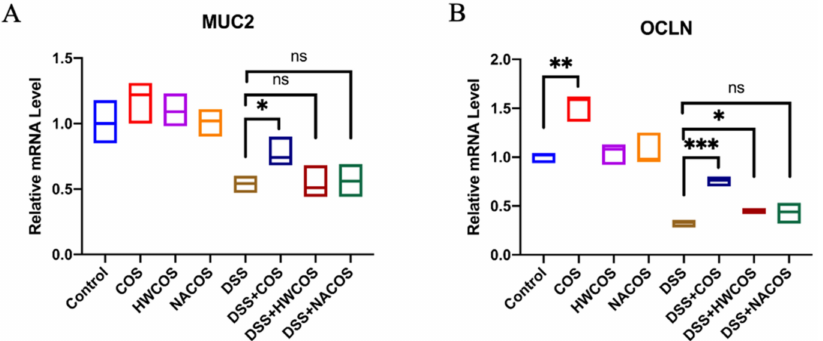
Figure 3. Effect of COS, HWCOS, and NACOS on the mRNA level of MUC2 in HT-29 and OCLN in Caco-2 cells. Cells were damaged by 2% (wt/vol) of DSS for 24 h, followed by treatment with 200 µ g/mL of COS, HWCOS, and NACOS. After 24 h of incubation, the mRNA level of MUC2 in HT-29 cells ( A ) and OCLN in Caco-2 cells ( B ) were determined by quantitative real-time PCR. The average value of the data was calculated ( n = 3; ns, not significant, * p < 0.05, ** p < 0.01, *** p < 0.001). Error bar represents the standard deviation. Data represent the typical situation of three independent